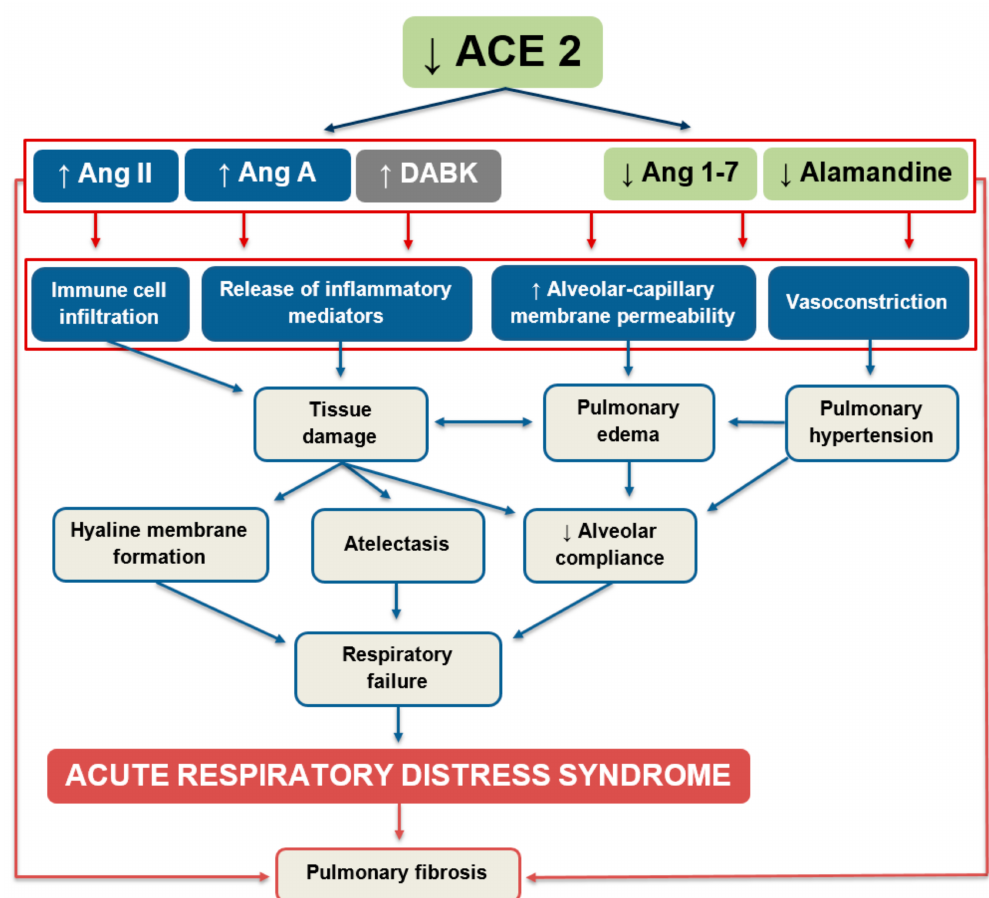
Figure 2. Putative role of the renin–angiotensin system in the progression of acute lung injury. ACE2—angiotensin-converting enzyme 2; Ang II—angiotensin II; Ang A—angiotensin A; DABK—des-Arg 9 -bradykinin; Ang 1–7—angiotensin